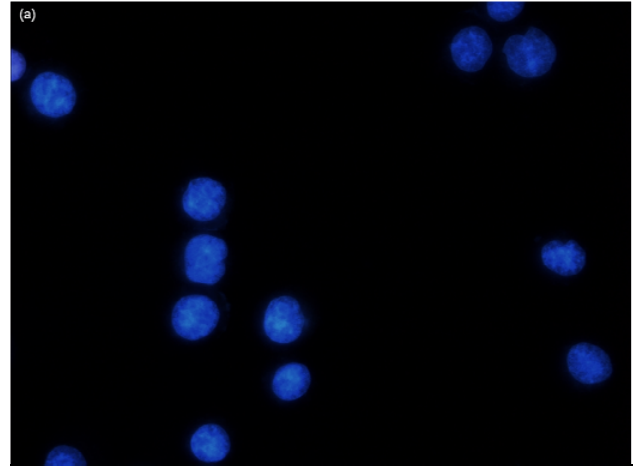
Figure 2. Nuclear morphological changes of HT-29 cells by NRAF. ( a ) Untreated control cells. After exposure to 50 µg/mL of NRAF. ( b ) and 100 µg/mL of NRAF. ( c ) for 24 h, when stained with Hoechst 33342 and PI. Arrows indicated early (e.g., chromatin condensation, cell shrinkage and nuclear fragmentation) and late apoptotic morphological changes. Magnification: 630×. Arrow 1 indicates chromatin condensation, 2 late apoptosis, 3 cell shrinkage, 4 DNA